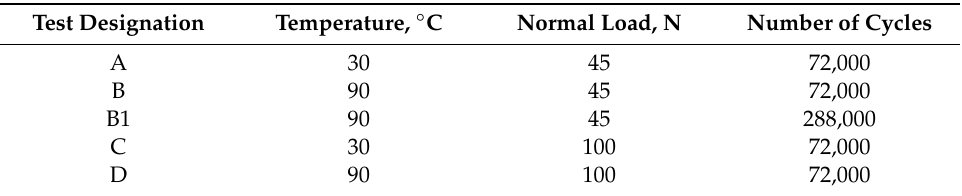
Table 1. Experimental conditions under